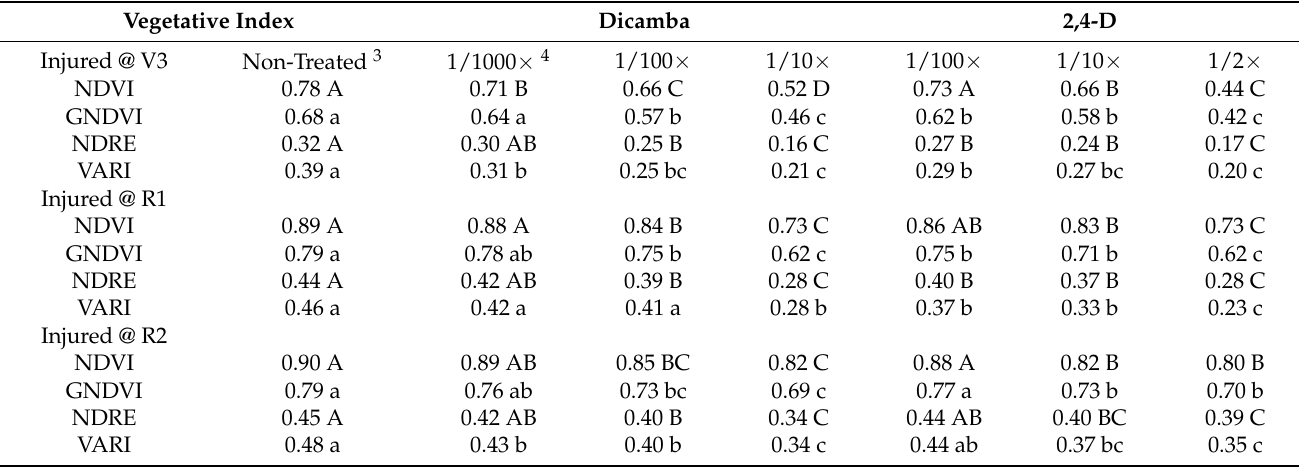
Table 1. ANOVA of herbicide injury treatment effects on vegetative index values 14 days after herbicide injury treatments 1,2 . Vegetative